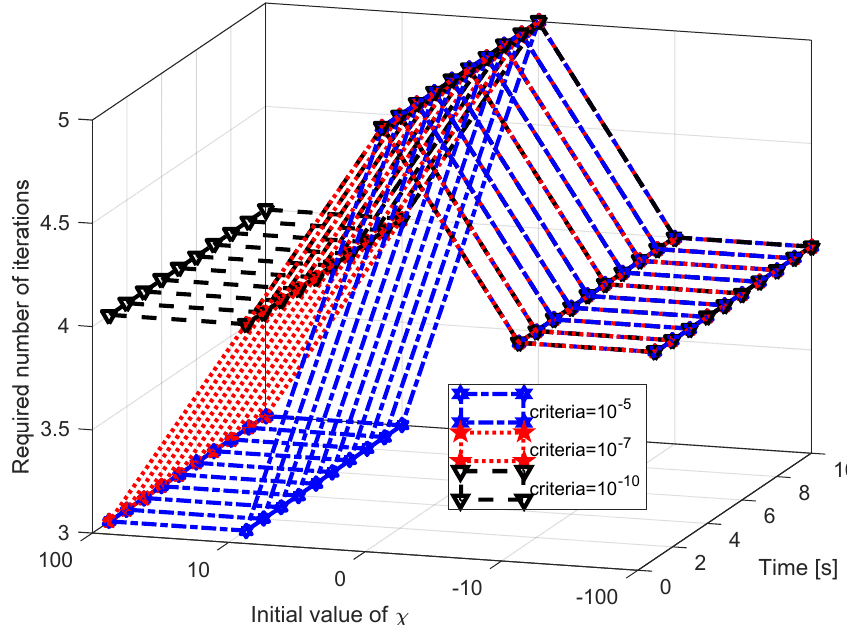
Figure 5. Influence of the initial conditions on the speed of convergence of the Newton method and the number of iterations in the problem solved.